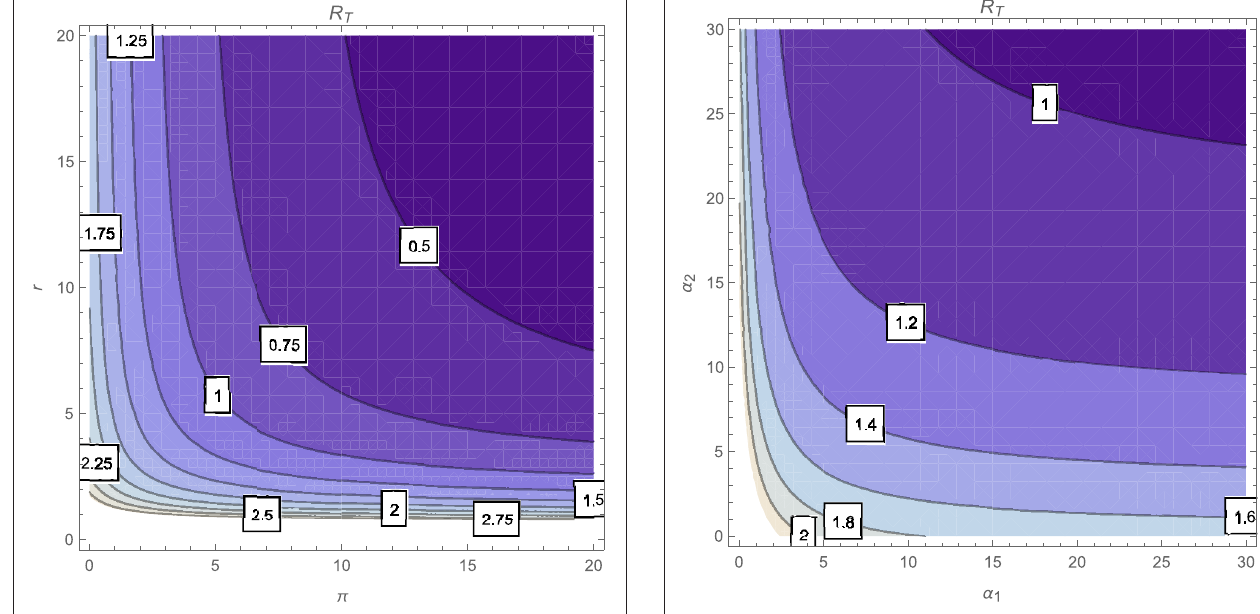
FIGURE 2 | Contour plot of R T as a function of π and r .